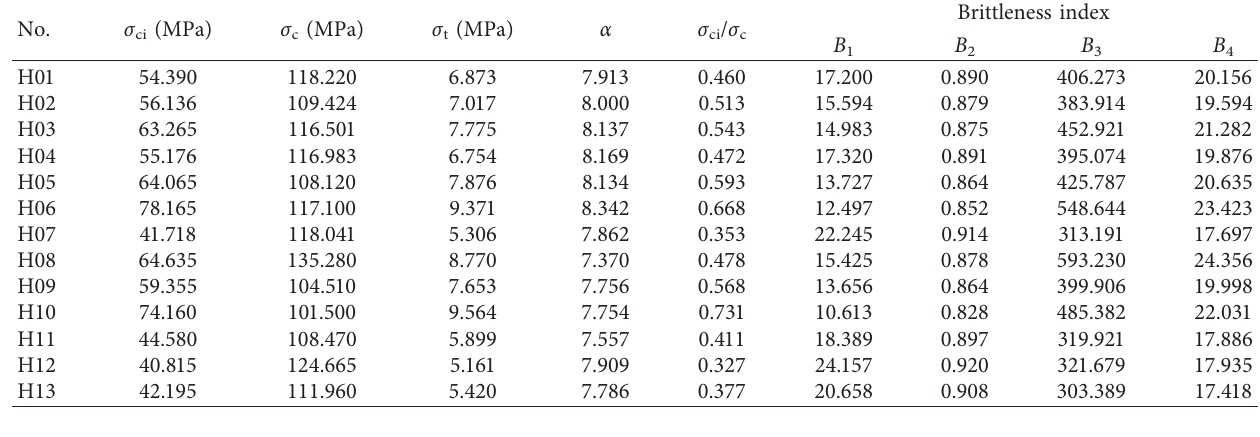
Table 1: Summary of mechanical parameters of granite samples.